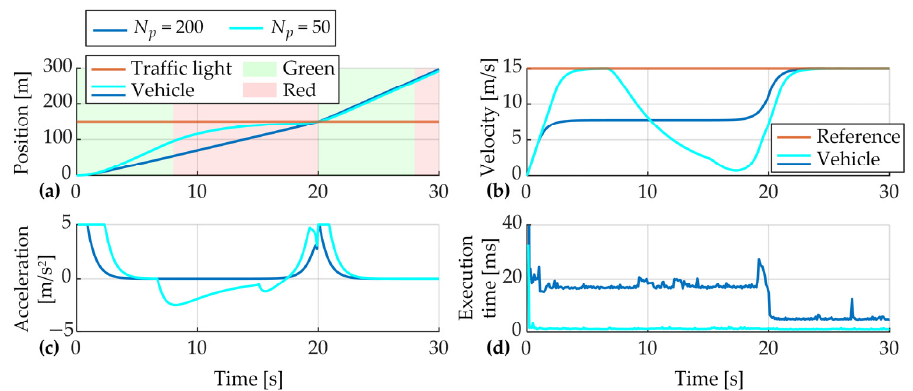
Figure 7. Comparative responses position ( a ), velocity ( b ), acceleration ( c ) and execution time ( d ) of linear MPC systems for prediction horizon lengths N p = 200 and N p = 15.